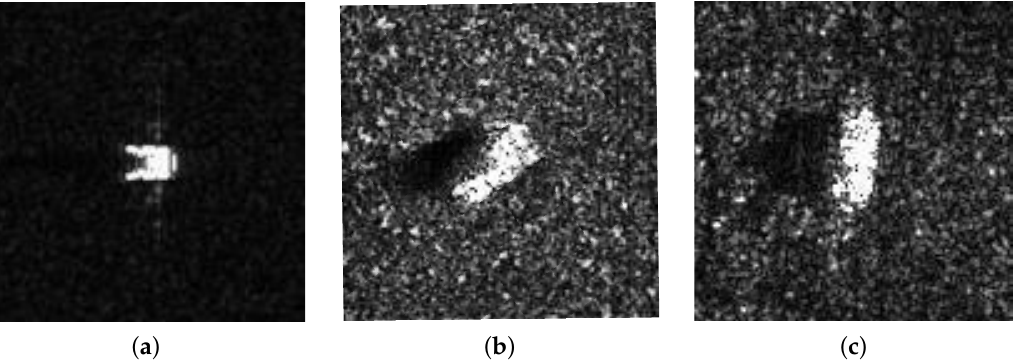
Figure 5. Presentation of three kinds of SAR images. ( a ) Original simulated SAR image. ( b ) Recon- structed simulated SAR image. ( c ) X NSP